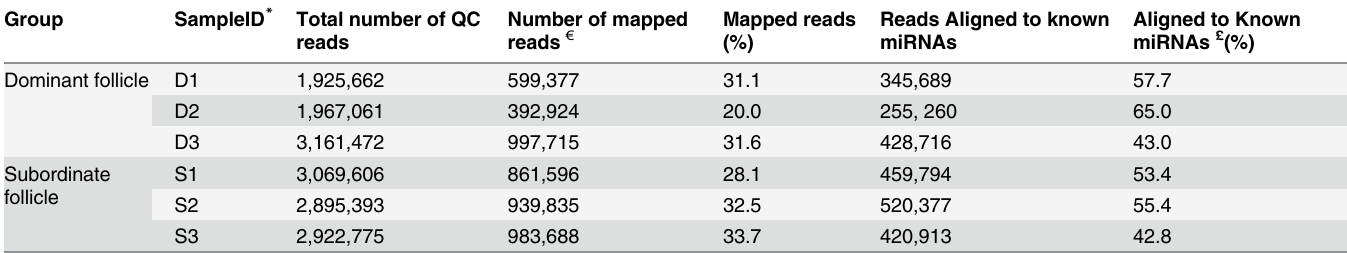
Table 1. Summary of sequence reads alignment to bovine reference genome and known miRNAs annotated in miRBase. Group SampleID * Total number of